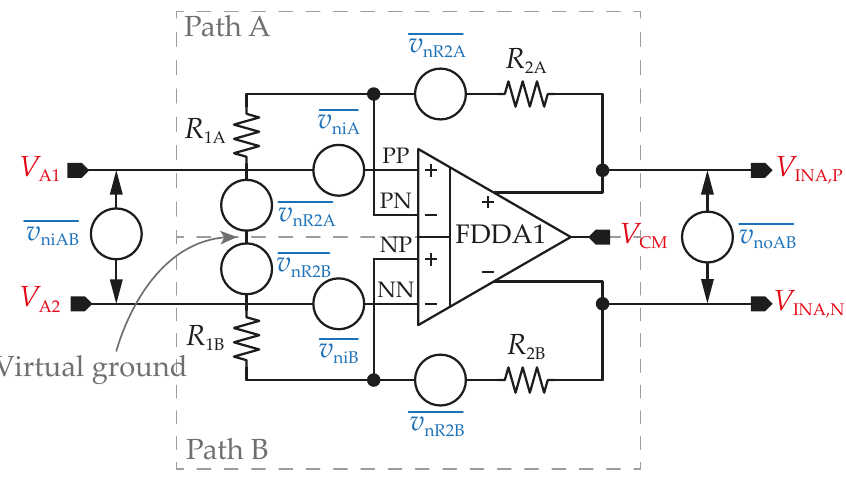
Figure 8. FDDA1 noise